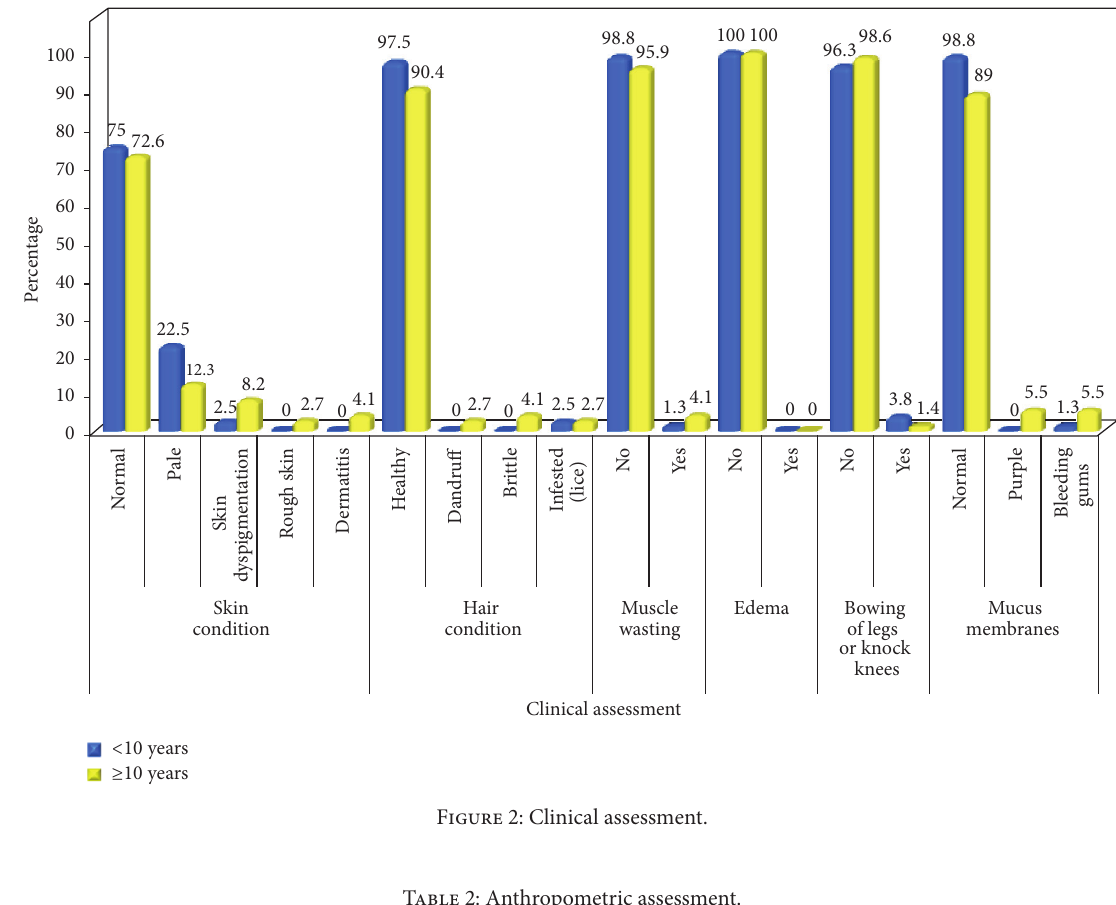
Table 2: Anthropometric